Question: What form of chart is displayed?
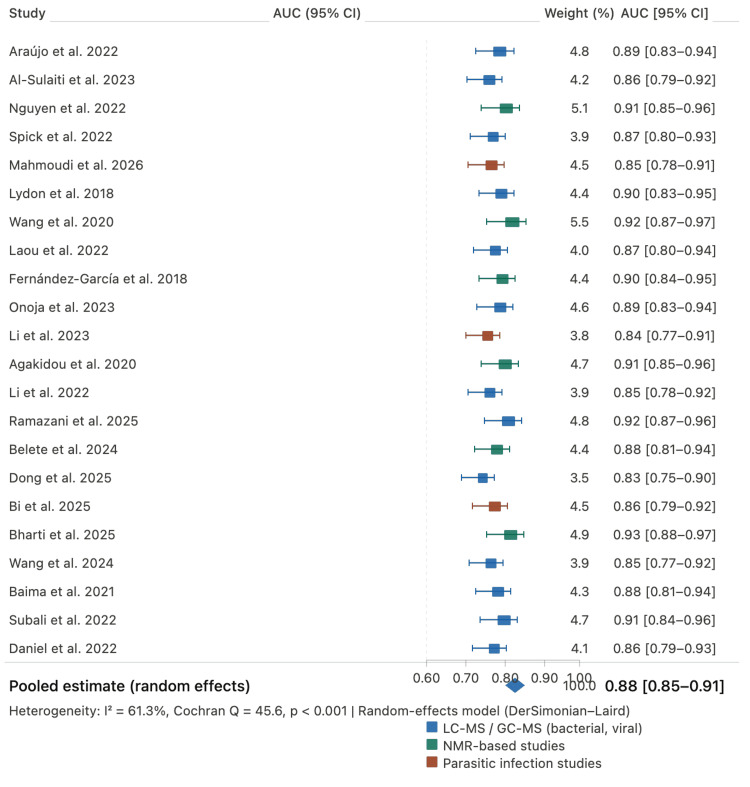
Answer: forest